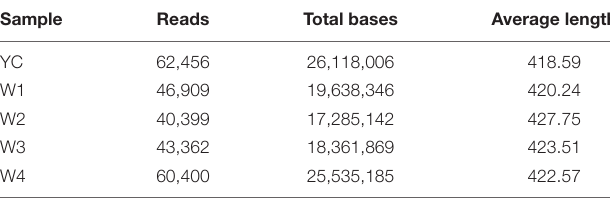
TABLE 1 | Sequencing analysis of 16S rRNA gene of bacterial communities in all five samples.